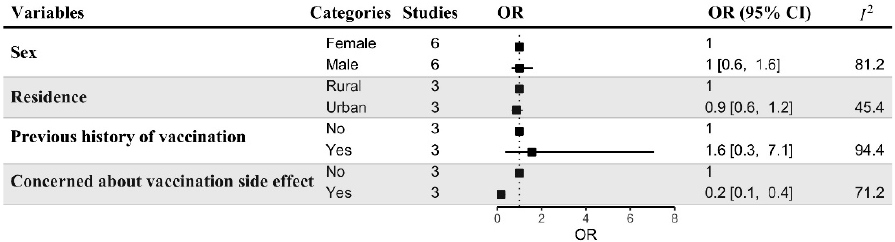
Figure 8. Predictors of COVID-19 vaccination acceptance among healthcare students.